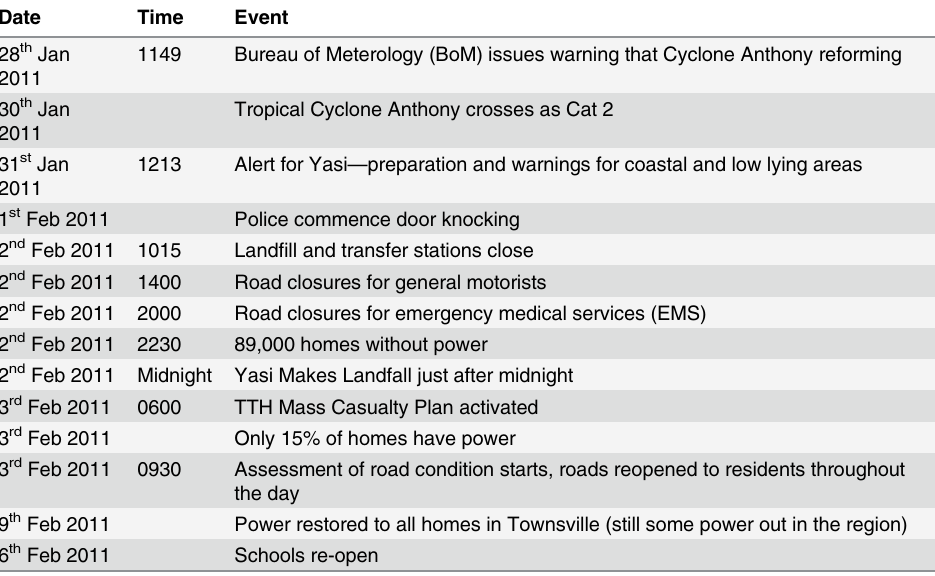
Table 1. Timeline of Cyclone